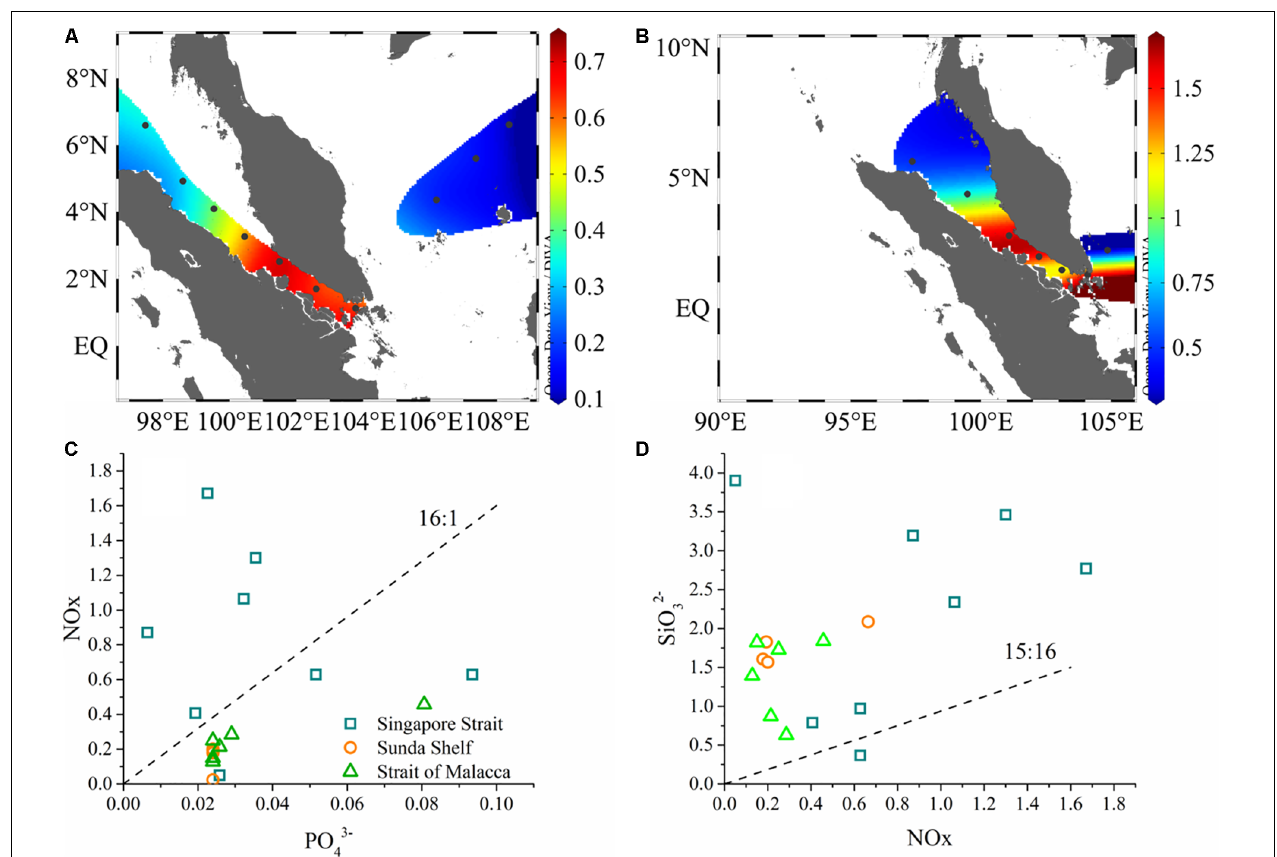
FIGURE 3 | Horizontal distribution of chlorophyll a ( A 2017, B 2018) and nutrient ratios (N:P, Si:N) (C,D) of two